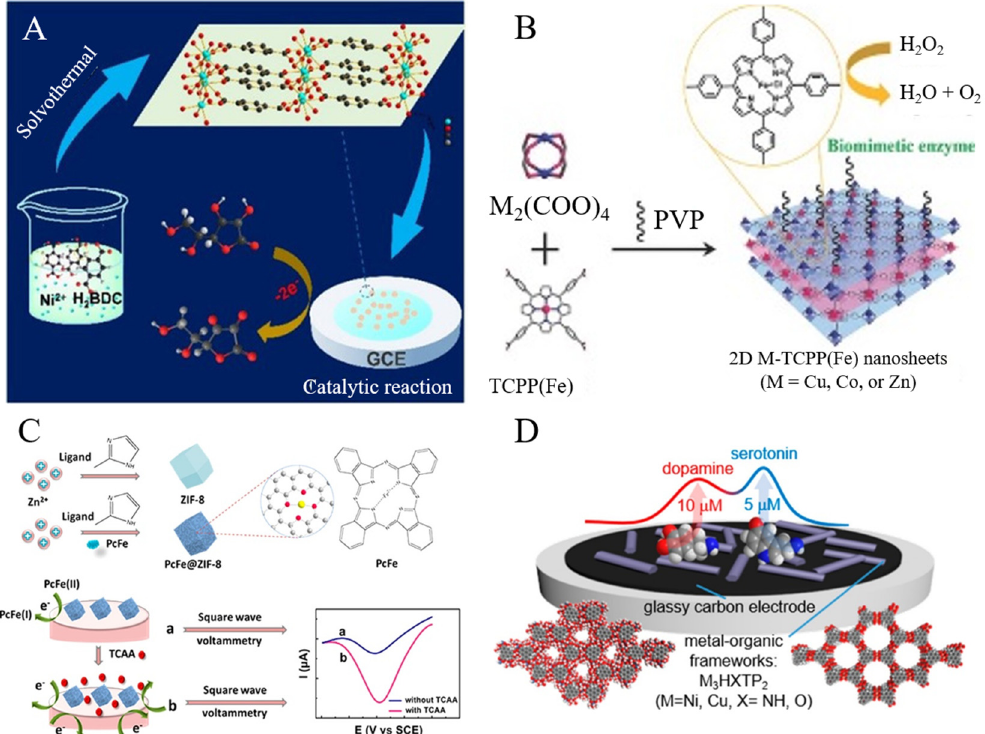
Figure 1. ( A ) Schematic illustration of the synthesis of the Ni − MOF and the Ni − MOF applied for catalyzing AA. Reprinted with permission from Ref. [66]. Copyright 2018, Wiley-VCH. ( B ) Schematic illustration of two-dimensional bimetallic MOF nanosheets applied for catalyzing H 2 O 2 . Reprinted with permission from Ref. [67]. Copyright 2016, Wiley-VCH. ( C ) Schematic illustration of ZIF-8 and PcFe@ZIF-8 synthesis process and the electrochemical sensing mechanism for TCAA determination. Reprinted with permission from Ref. [68]. Copyright 2019, American Chemical Society. ( D ) Schematics of 2D layered conductive MOFs − based electrochemical sensor for TCAA determination. Reprinted with permission from Ref. [69]. Copyright 2020, American Chemical Society.